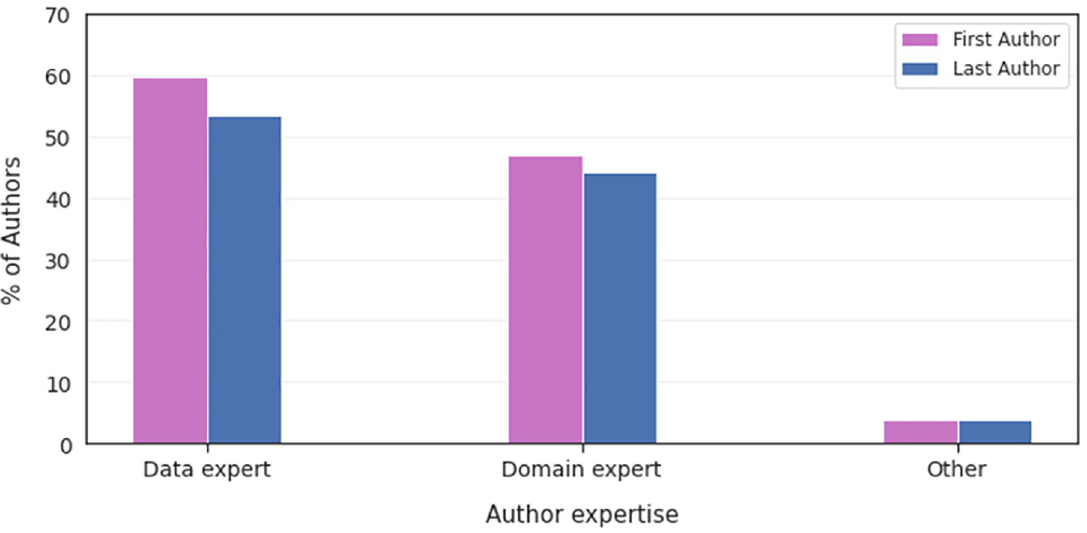
Fig 5. Distribution of first and last author expertise in AI in medicine.